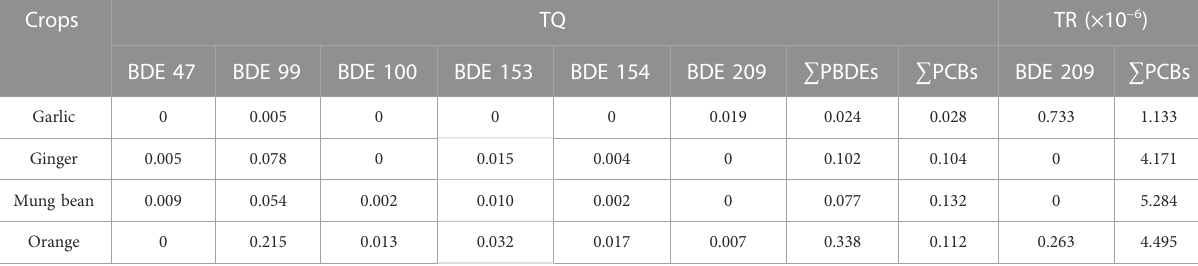
TABLE 4 Carcinogenic risks and non-carcinogenic risks of PCBs and PBDEs in crops. Crops